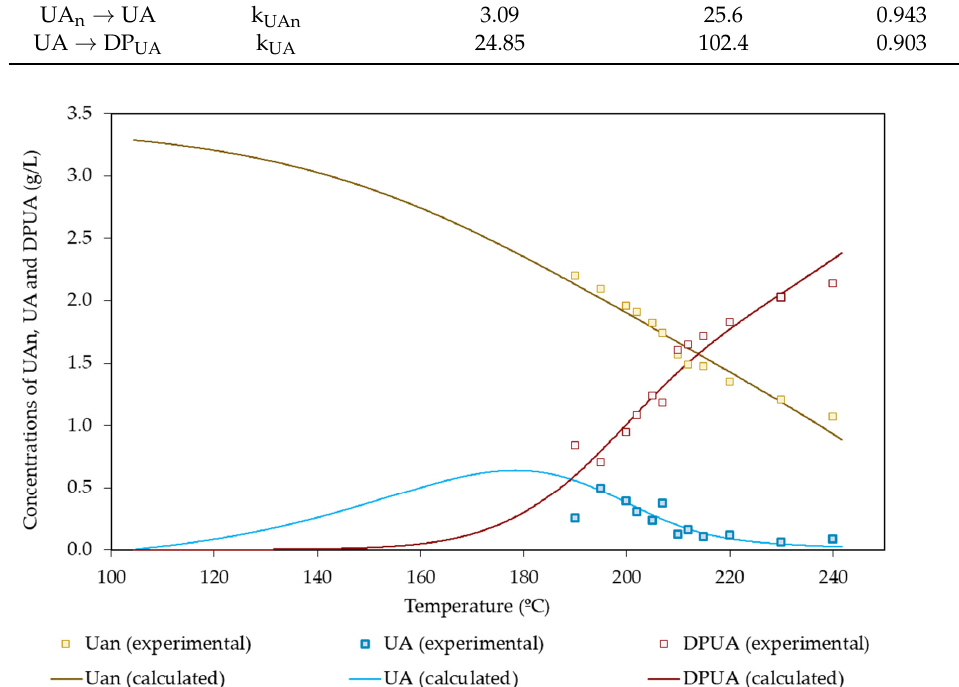
Figure 7. Experimental and calculated values of variables measuring the hydrolysis of uronic ac ‐ ids.